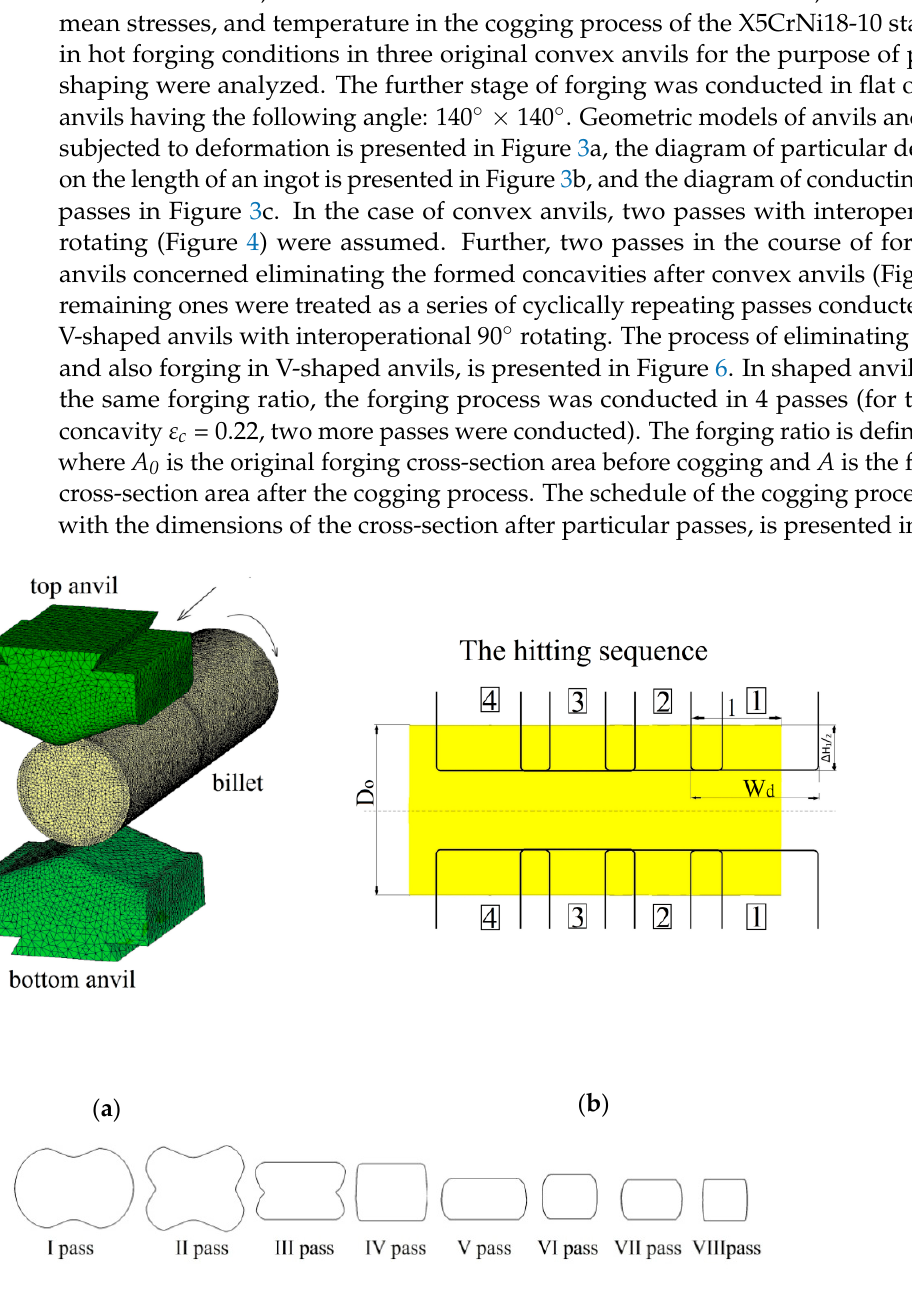
( b ) Figure 4. Order of forging the workpiece with convex anvils ( α c = 135°, 150°, and 165°), ( a ) after the first pass, ( b ) after the second pass. The specific character of the forging process in convex anvils brings about the fact that local strains on the section of a material subjected to deformation after the first pass (Figure 4a) were diversified, nevertheless, they guaranteed a good plastic forming in the limited workability zone. In the area situated adjacently to the surface of anvils, it was observed that there were high values of the effective strain, whereas the lateral zones of forging were the area of those values being smaller. The application of the second pass in convex anvils (Figure 4b) brought about significant changes in the kinematics of metal flow and a significant increase in homogeneous distribution of the effective strain. For that very reason, for conducting the forging process, two passes in convex anvils were applied. ( b ) Figure 5. Order of forging the workpiece with a concave cross-section with flat anvils ( a ) after the first pass, ( b ) after the second pass.